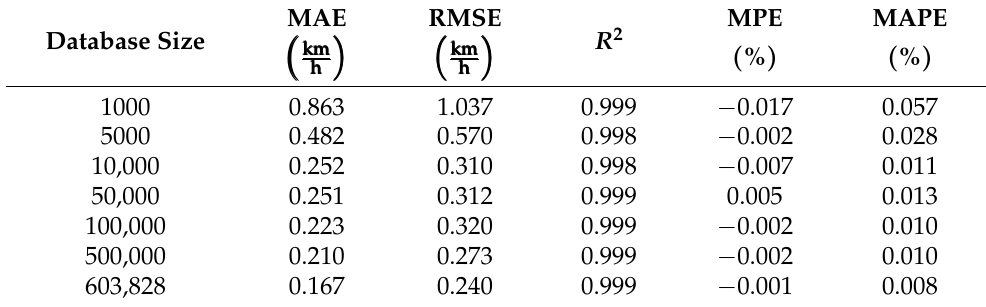
Table 4. Evaluation metrics for the TNN model when trained with different database